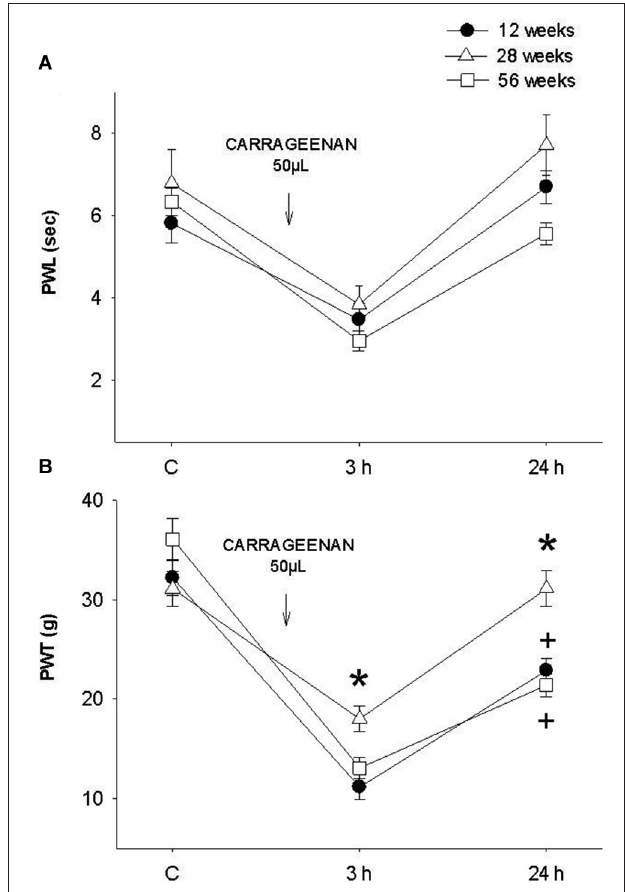
FIGURE 3 | (A) Thermal and (B) mechanociceptive responses in young (12 weeks old, black dots), adult (28 weeks old, white triangles) and old (56 weeks of age, white squares) rats in control, 3 h and 24 h after the first application of intraplantar CAR. In the mechanociceptive test (B) adult rats present average values significantly higher than those of young and old rats at 3 h ( F = 10.327, * p = 0.001) and 24 h ( F = 12.403, * p = 0.001) posterior to inflammation. Notice that the values of young and old rats were significantly smaller at 24 h and different to those of the adult group (+ p = 0.01). Data are expressed as mean ± SE.